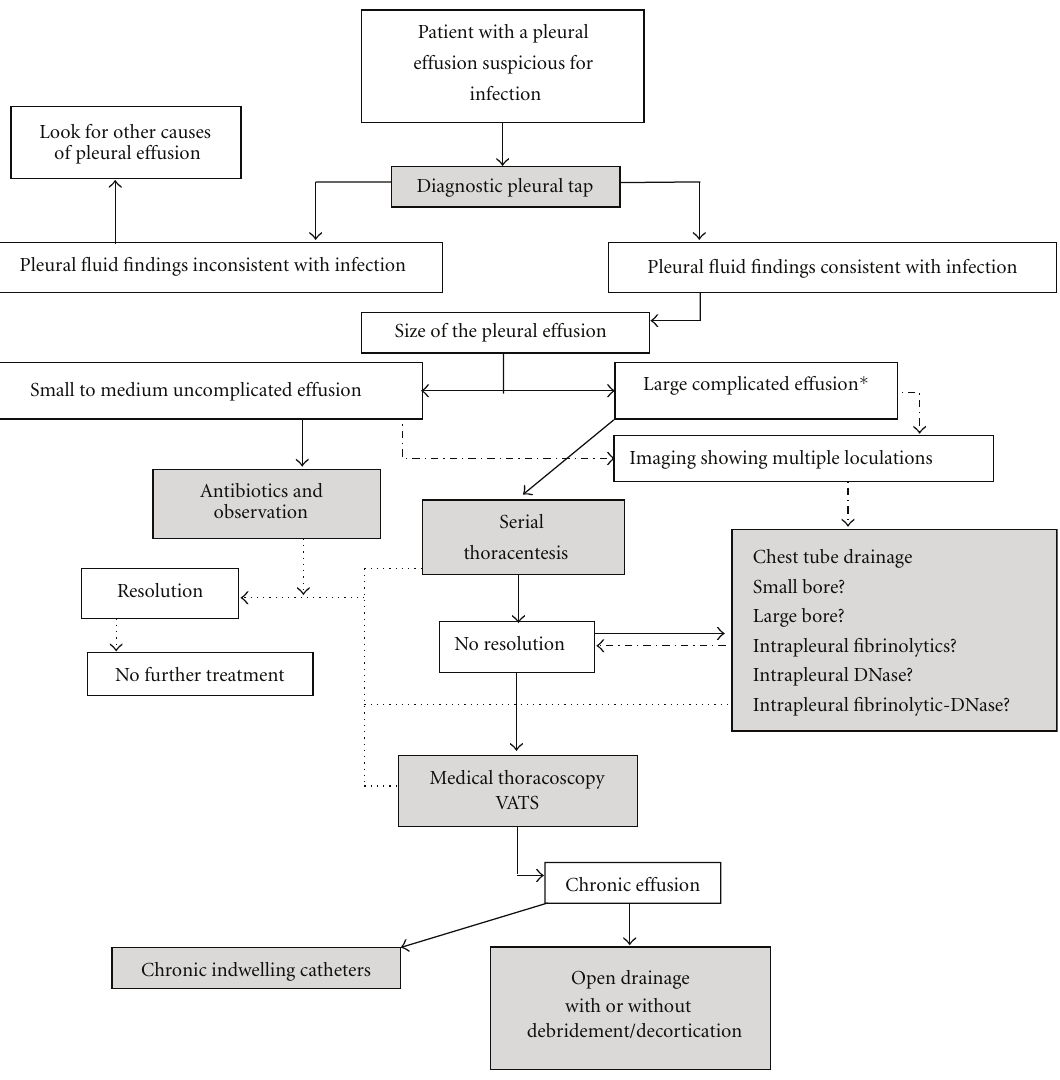
Figure 5: A schematic flow chart summarizing the various treatment modalities available for managing pleural infection and various stages where each of them may be used. Decisions regarding timing of each treatment option may vary according to institutional expertise. ∗ Empyema or e ff usions with either gram stain or culture positive, pH < 7.2, glucose < 60 mg/dL, LDH <